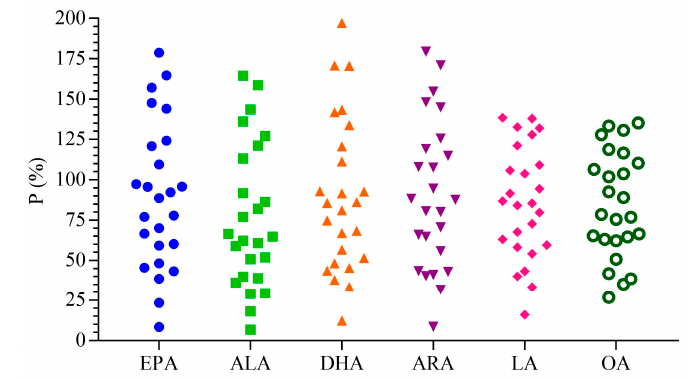
Figure 8. The di ff erence of PUFAs contents in 27 batches of Oviductus Ranae Figure 8. The difference of PUFAs contents in 27 batches of Oviductus Ranae samples.